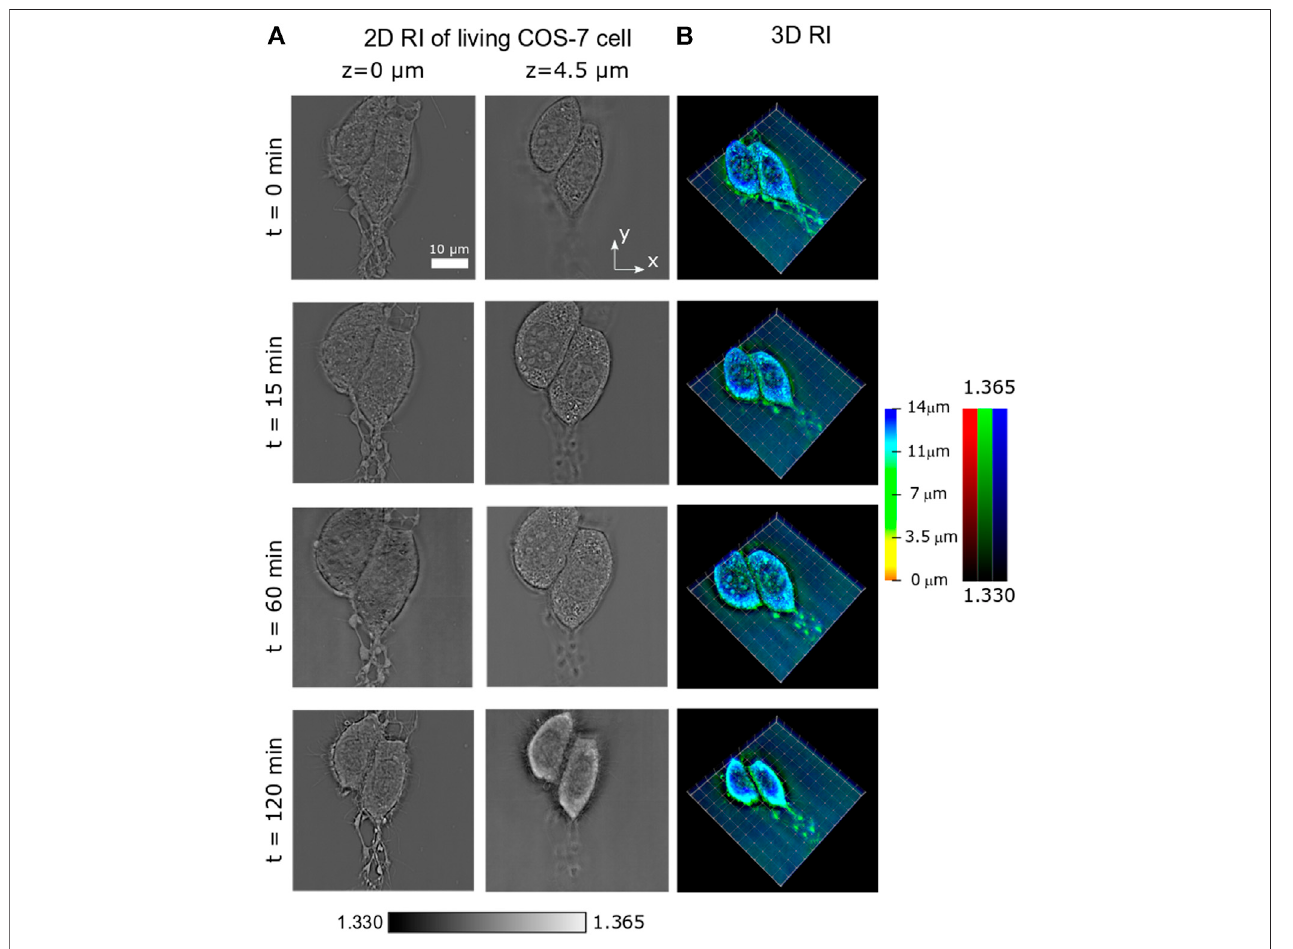
FIGURE 4 | Temporal evolution of the RI of a COS-7 cell undergoing necrosis. (A) 2D slices of the RI at two different planes z (cid:2) 0 μ m and z (cid:2) 4.5 μ m. (B) 3D rendering of the cell RI in four moments of time.